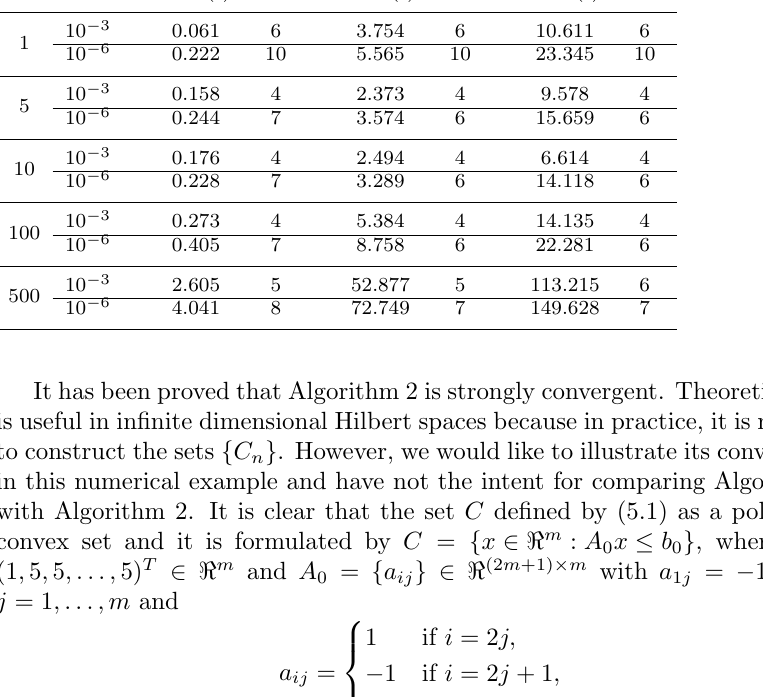
Table 1. Experiment for Algorithm 1 N=2 N=50 N=100 m TOL CPU(s) Iter. CPU(s) Iter. CPU(s)